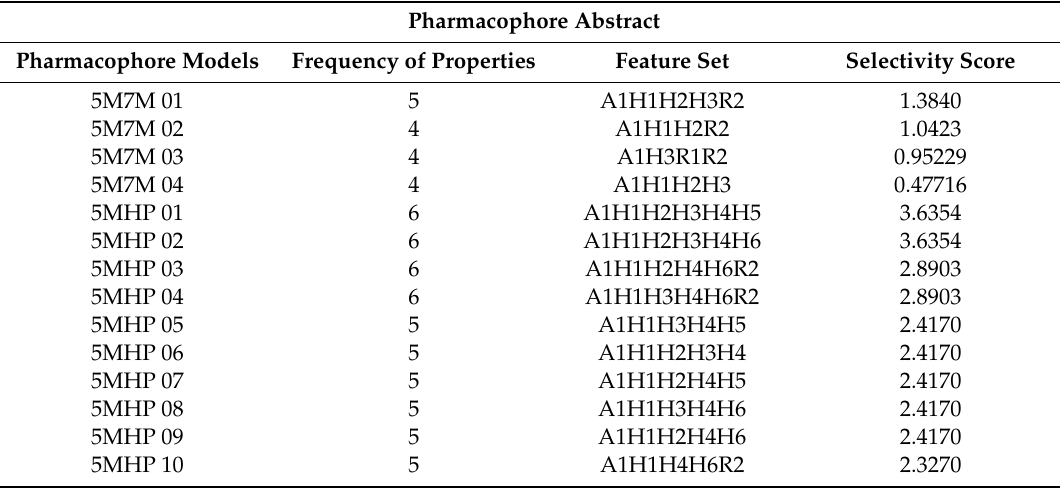
Table 1. The summary of pharmacophore models 5M7M